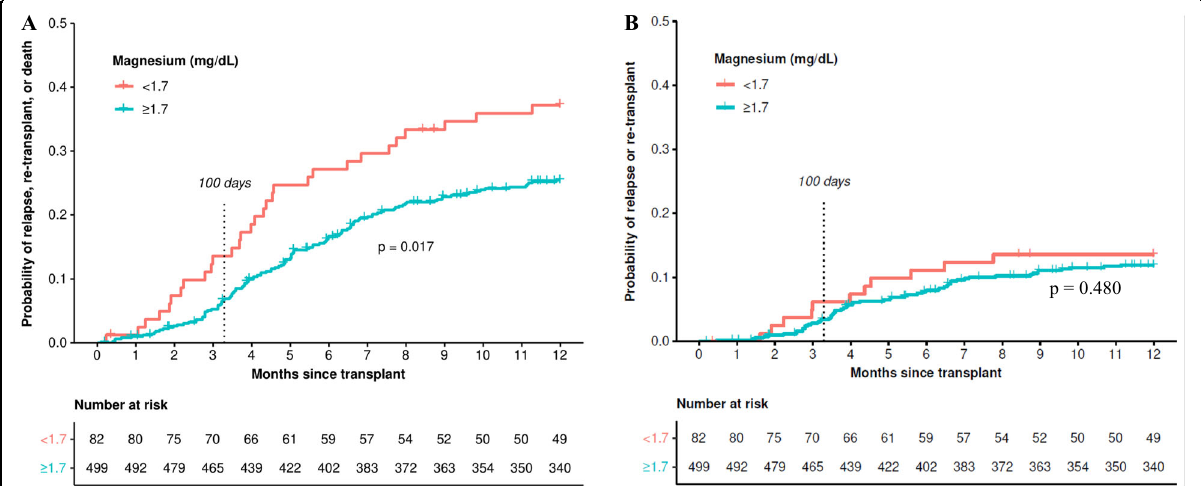
Fig. 1 Event free and relapse free survival curves. A Event-free survival of patients with diffuse large B-cell lymphoma undergoing autologous stem cell transplant by premyeloablative serum magnesium level between 1998 and 2020. Log-rank test p = 0.017. B Relapse free survival of patients with diffuse large B-cell lymphoma undergoing autologous stem cell transplant by premyeloablative serum magnesium level between 1998 and 2020. Log-rank test p =